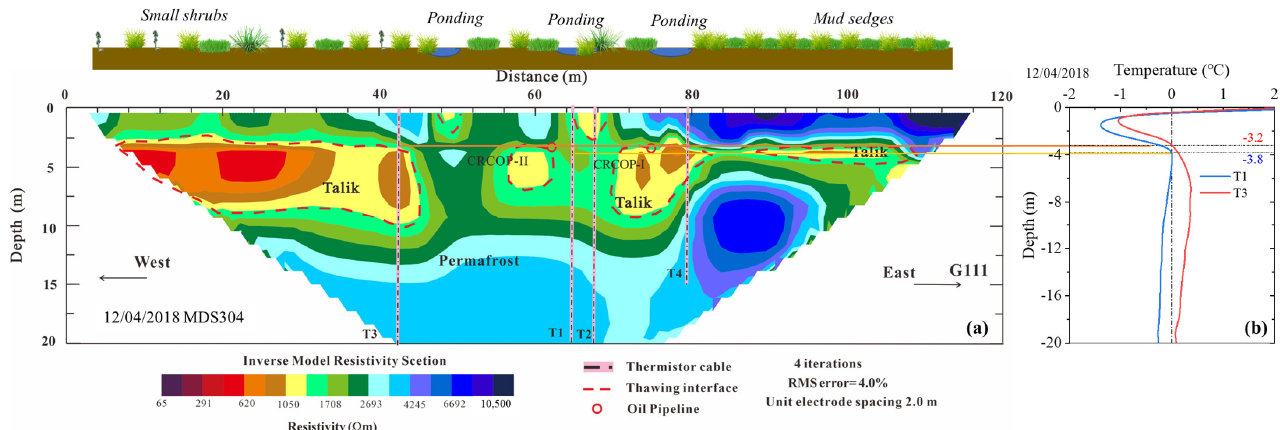
Figure 9. On 12 April 2018, an inversion profile of the ERT test results with an RMS error of 4.0% was obtained at the MDS304 site (Profile 1) ( a ), and the curve of ground temperature with a depth of borehole T1 and T3 ( b ). Note: T1,…, T4 is a ground temperature borehole; CRCOP-I: the CRCOP’s first line; CRCOP-II: the CRCOP’s second line. On 6 April 2019, an ERT test was performed at the same section of the MDS304 site. The ERT test was conducted at a polar distance of 2 m, using 61 electrodes and a